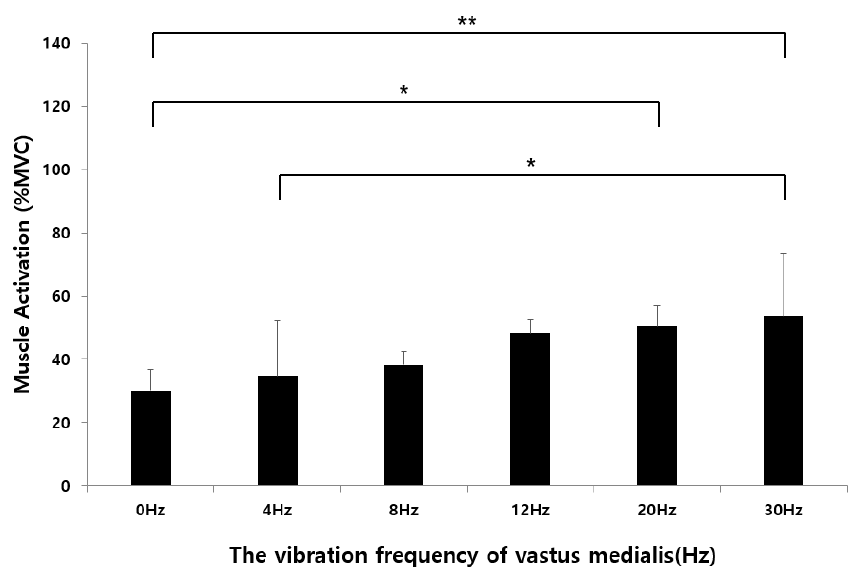
Figure 6. Results of vastus medialis muscle activation according to the vibration frequency conditions (* p < 0.05, ** p <